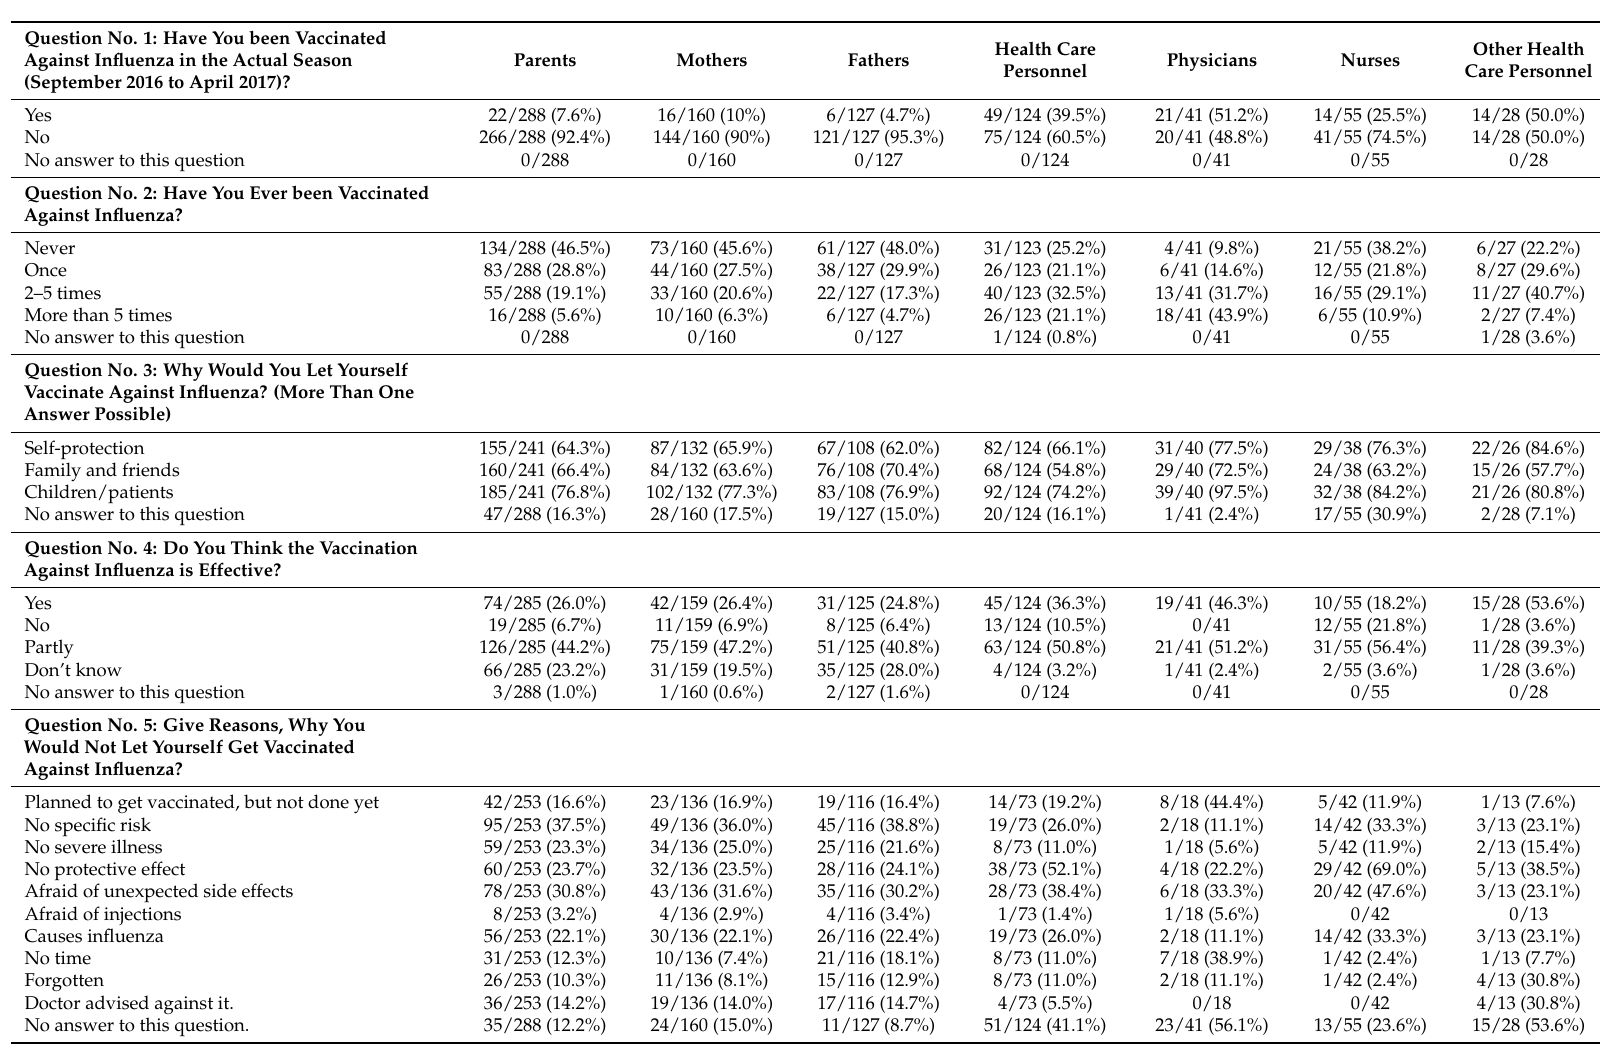
Table 1. All questions and answers provided in response to the vaccination